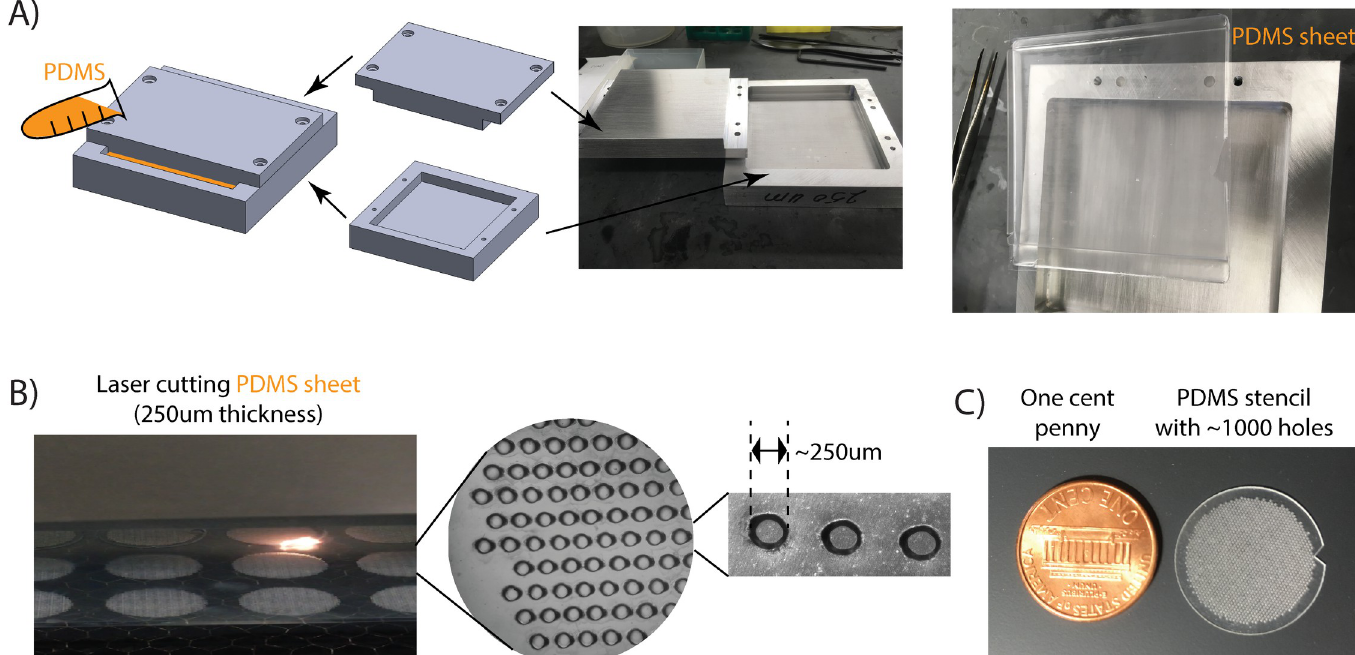
Fig 1. We have fabricated reusable PDMS stencils by laser cutting. (A) We used a metal mold, with a 250 μ m gap, to manufacture a degassed PDMS sheet of 250 μ m thickness (more details described in Materials and Methods). Worth mentioning, PDMS sheets with similar thickness are also commercially available. (B) We used a laser printer to penetrate holes (~250 μ m diameters) on the PDMS sheet (more details in Materials and Methods). (C) About 1000 holes were created in a ~19mm diameter area, a size compatible to pattern a 35mm glass-bottom cell culture dish.